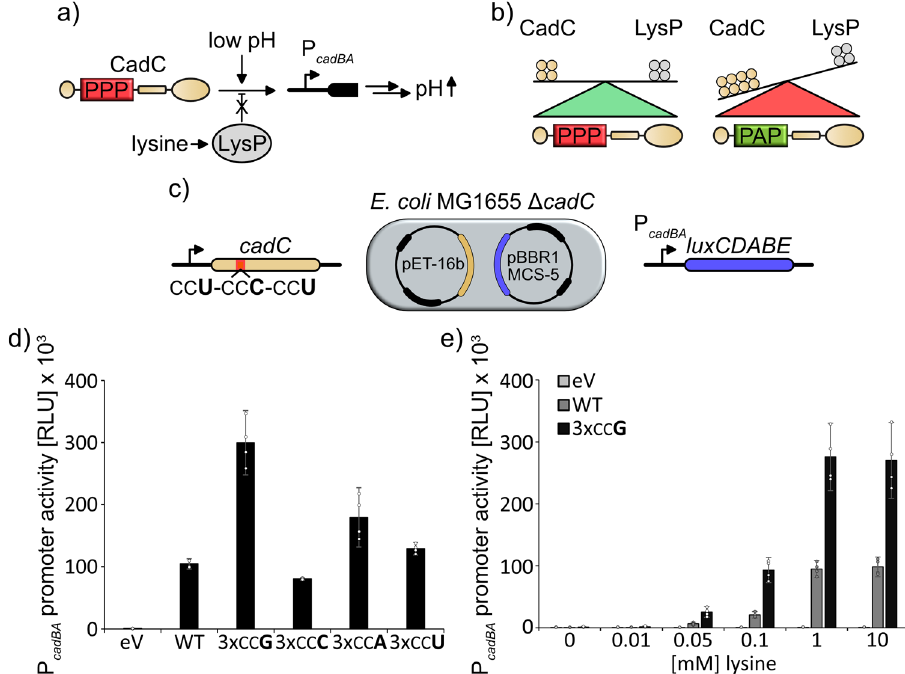
Fig. 7 Codon choice modulates protein expression and ensures physiological protein stoichiometry of the Cad system. a The Cad system. CadC is a pH sensor that induces expression of its target genes at low pH by binding to the cadBA promoter (P cadBA ). Expression of the corresponding gene products ultimately leads to an increase in pH. The lysine dependency of the acid stress response depends on stoichiometric expression of CadC and the co-sensor LysP. b The equilibrium of the protein copy numbers of CadC and LysP is ensured by a triproline motif within the CadC primary structure. Absence of the triproline results in deregulation of the acid stress response due to increased CadC copy number. c Reporter system used to test the cadC translation ef fi ciency. E. coli MG1655 Δ cadC cells were transformed with pET-16B vectors encoding for wild type or proline codon-exchanged variants of CadC. Cells were cotransformed with pBBR1MCS-5 vectors carrying the lux genes under control of the P cadBA promoter. P cadBA promoter activity was assessed by measuring luminescence emission and used as a proxy for CadC copy number 14 . d P cadBA promoter activity under inducing conditions (pH = 5.8; 10 mM lysine) upon expression of wild-type CadC or proline codon-exchanged CadC variants where all proline codons in the pausing motif have been substituted by the same codon. n = 4. e P cadBA promoter activity at increasing external lysine concentrations. P cadBA induction when cadC contains the natural codon composition is shown in dark gray. P cadBA induction when cadC contains only CCG codons at the relevant PP-motif is shown in black. n = 4, Error bars indicate 95% con fi dence